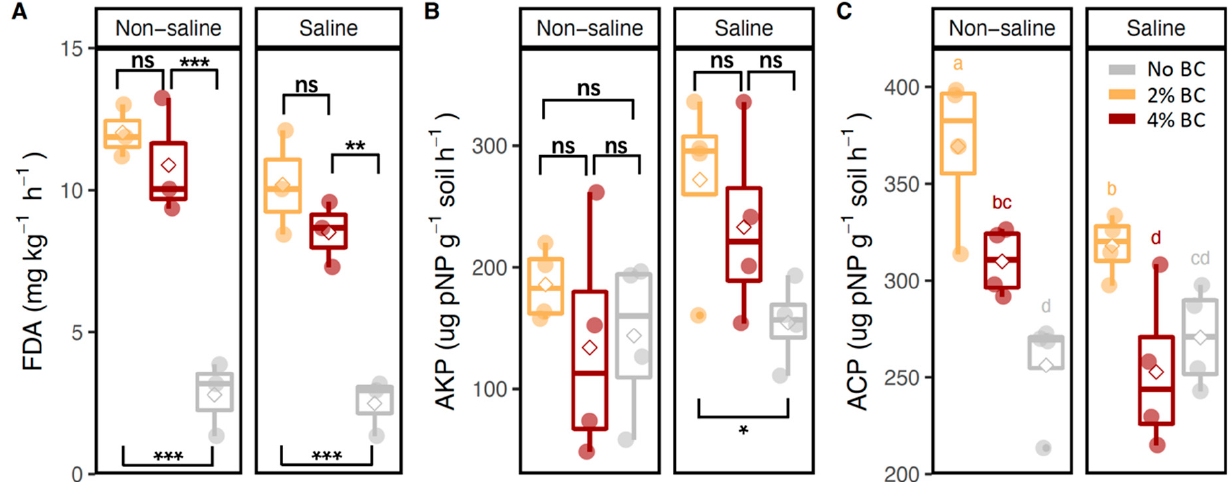
Figure 2. Effect of biochar application (2% and 4%) on soil FDA hydrolase ( A ), alkaline phosphomonoesterase, AKP ( B ), and acid phosphomonoesterase, ACP ( C ) activities in purslane planting systems under saline and non-saline conditions. The top and bottom of the box represent 75% and 25% quantiles, respectively. The bars of the box represent maximum and minimum values of observations. The line in the box represents the median. The dots represent every single observation. The rhombus in the box represents the mean. Codes (* p < 0.05, ** p < 0.01, and *** p < 0.001; ns—not significant) in ( A , B ) indicates the significance of each paired comparison for the biochar factor. Letters within each column in ( C ) are significantly different based on Duncan’s test.